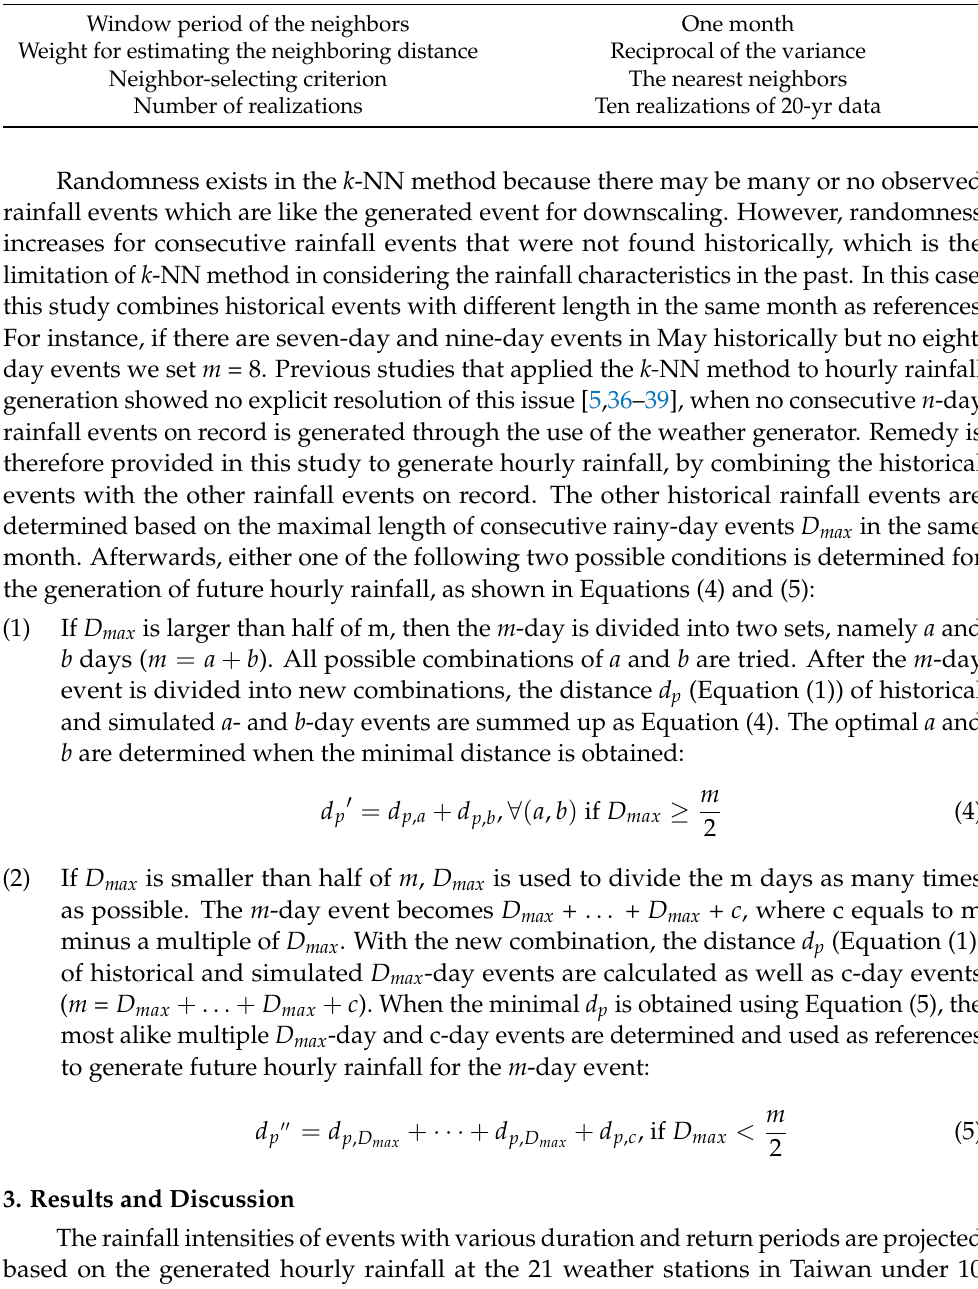
Table 3. Parameters of the k- NN method used in the study. Parameter Configuration Window period of the neighbors Weight for estimating the neighboring